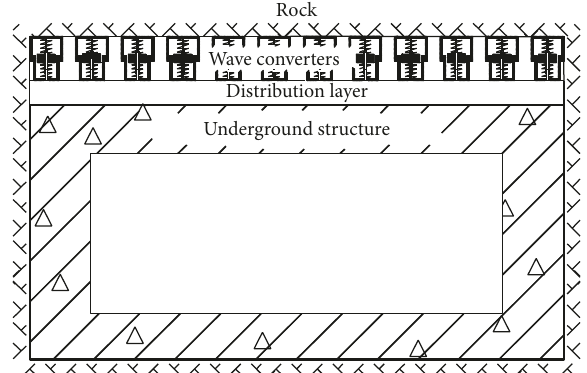
Figure 1: Schematic of the new blast-resistant method.